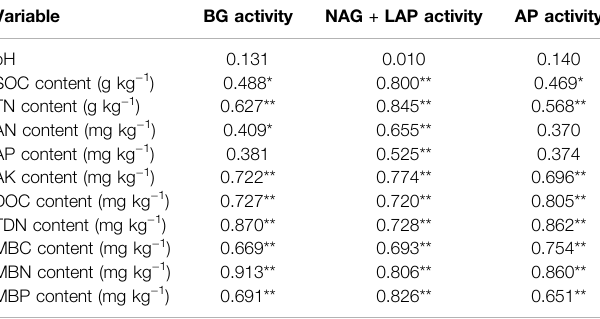
Asterisks indicate signi fi cant relationships ( p < 0.05). See Materials and methods for abbreviation de fi